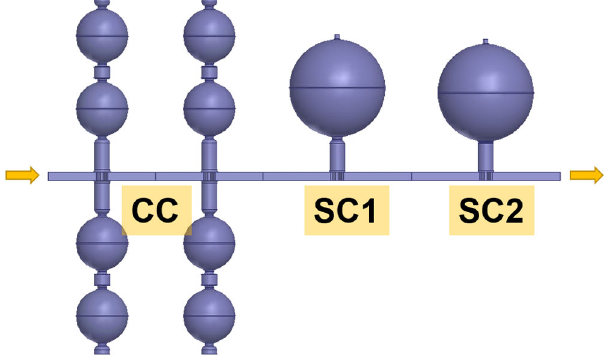
FIG. 2. Geometry of the expanded polarizer and the transient E-field distribution with 1-W input power fed from port 1.